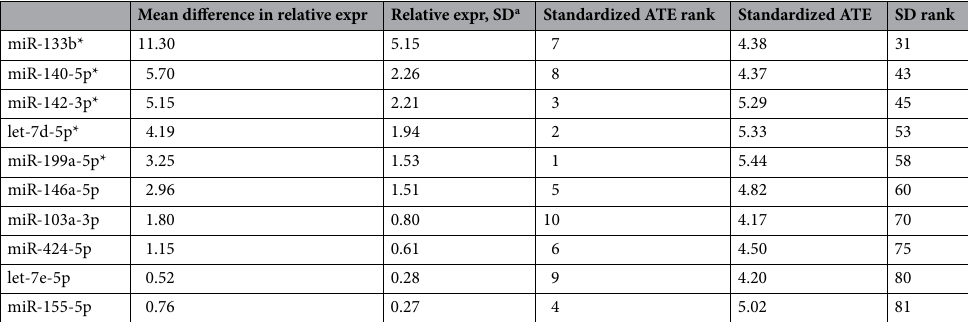
Table 2. Top 10 miRs ranked by standardized average treatment effect (ATE) & standard deviation (SD) of miR levels from IS and SS groups. ATE, average treatment effect: weighted mean difference of miR levels between SS and IS; Standardized ATE, ATE divided by bootstrapped SD of ATE; Expr, expression. SD, standard deviation. *Top 5 miRs based on combined standardized ATE ranking then, SD ranking. a Unweighted SD across IS and SS.